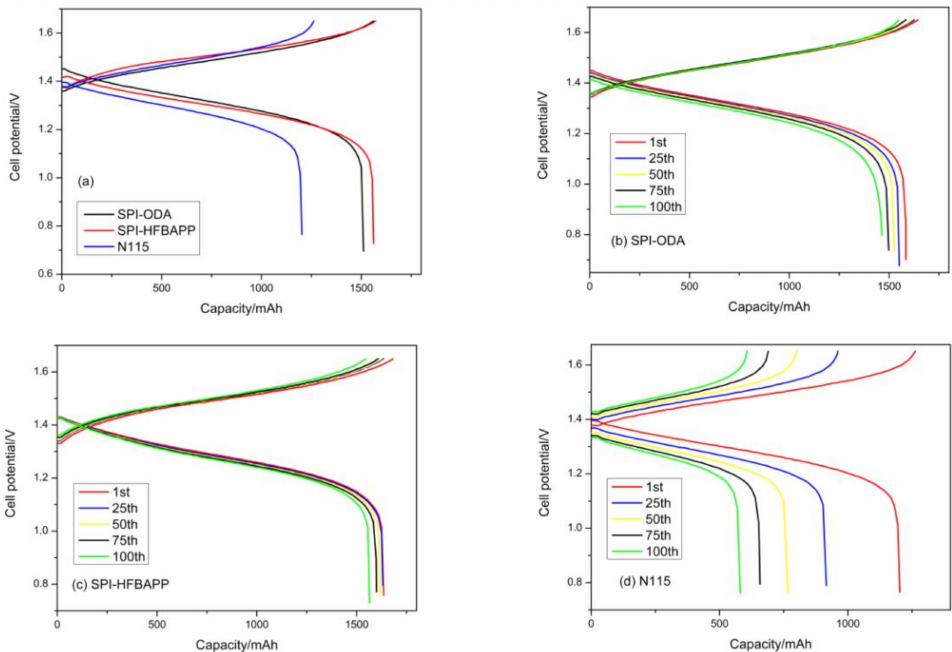
Figure 4. Charge–discharge cures of the VRFB with SPI membranes and N115 at current density of 100 mA · cm − 2 ; ( a ) is the capacity of the first cycle while ( b ), ( c ), and ( d ) are the capacities of different cycles.